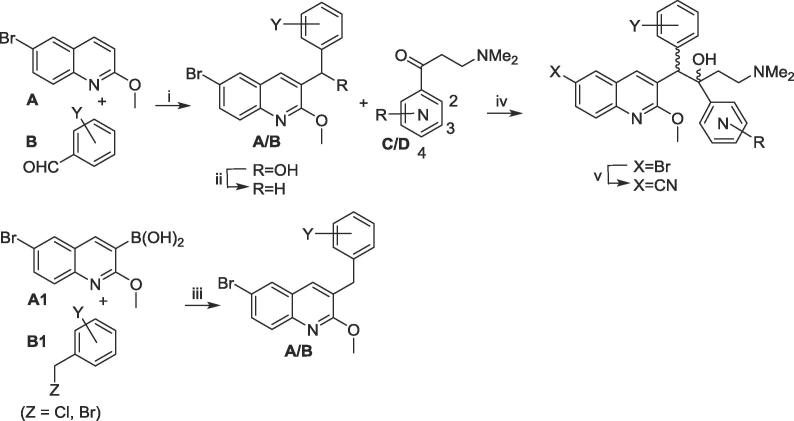
General synthesis of bedaquiline analogues. Reagents and conditions: (i) LiTMP, THF, −75 °C, 1.5 h then the appropriate aldehyde B, −75 °C, 4 h; (ii) Et3SiH, TFA, DCM; (iii) Cs2CO3, Pd(PPh3)4, PhMe/DMF, 110 °C (sealed tube), 5 h; (iv) LDA, THF, −75 °C, 1.5 h then the appropriate ketone C/D, then HOAc; (v) Zn/Zn(CN)2, Pd2(dba)3/P(o-tol)3, DMF, 50 °C, then separation of the diastereomers by SFC HPLC.